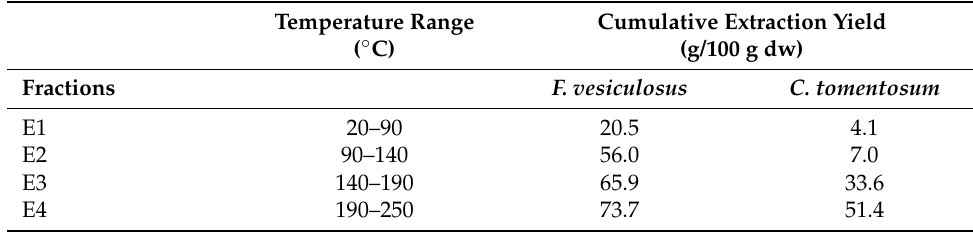
Table 2. Extraction yields of the SWE extracts.